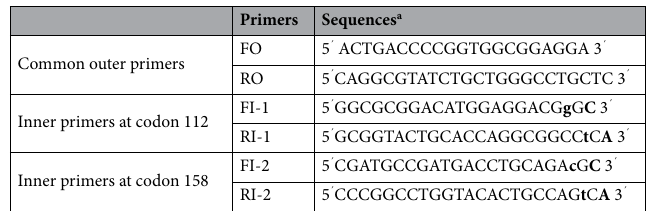
by a Nano-Drop 2000™ spectrophotometer (Thermo Fisher Scientific, USA). The extracted genomic DNA samples were stored at – 20 °C until genotyping. APOE genotyping. Using the multiplex tetra-primer amplification refractory mutation system polymerase chain reaction (Multiplex T-ARMS-PCR) method, the target regions in the APOE gene were amplified. In the Multiplex T-ARMS method, two allele-specific primers were used for each SNP, one for the mutant allele (FI-1, RI-2) and the other for the wild-type allele (FI-2, RI-1) and as well as two control primers (RO, FO) was used that amplify the whole fragment. One multiplex PCR reaction was needed for each DNA sample. In multiplex T-ARMS PCR, all six primers (FO, RO, FI-1, RI-1, FI-2, and RI-2) were used in a single reaction tube. Primer sequences have been shown in Table 3. A total volume of 20 µl of the reaction mixture was prepared for each PCR reaction as follows: 10 µl of TEMPase Hot Start 2 × Master Mix A BLUE (Amplicon, Denmark), 0.8 µl genomic DNA sample, 1.6 µl (8%) DMSO ( SinaClon BioScience , Iran), 0.5 µl (10 pmol/ µl) of each control prim- ers (RO, FO), 1 µl (10 pmol/ µl) of each allele-specific primer and 2.6 µl distilled water. No template control was performed for each experiment by adding 0.8 µl of water instead of sample DNA. The amplification reaction was performed in ABI Veriti thermal cycler machine ( Thermo Fisher Scientific, USA ). The PCR program was carried out with an enzyme activation step at 95 °C for 10 min, followed by 30 amplification cycles (30 s at 95 °C, 30 s at 67 °C, and 30 s at 72 °C) and a final extension at 72 °C for 7 min. The amplification products were separated by electrophoresis on 2% agarose gels ( SinaClon BioScience , Iran), containing 0.5 mg/L DNA gel stain ( SinaClon BioScience , Iran) and the image of bands visualized under the UV light and captured by gel documentation system (Syngene, UK). The amplification of 115 and 307 base pairs (bp) PCR products indicated the e3/e3 genotype. The presence of 253 bp amplicon showed a variant (C T) which indicated the e2 allele, and the presence of 444 bp amplicon indicated the e4 region variant (TC). The amplification of 514 bp amplicon in each PCR reaction was used as internal control amplicon to demonstrate successful PCR reaction by control primers (Supplementary File) 34 . Statistical analysis. Allele and genotype frequencies between case and control groups were compared for, significance using χ 2 ( Fisher’s exact test) . Odds ratio (OR) with 95% confidence intervals (CI) were used to describe the strength of association. SPSS software (version 25) was used for statistical analysis. All P-values were considered statistically significant for P < 0.05.